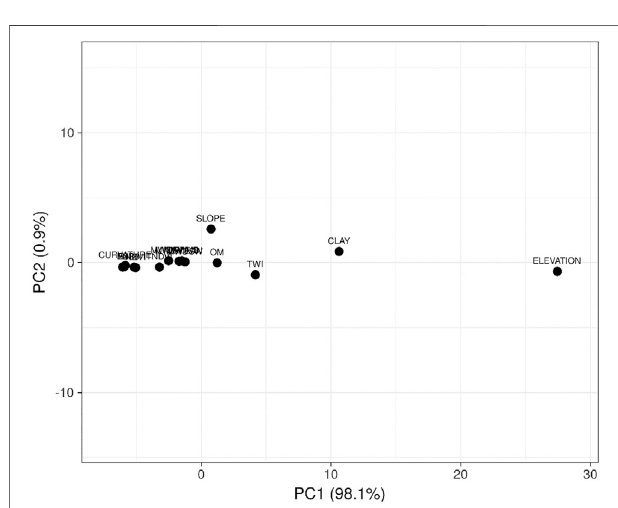
FIGURE 6 | PCA scatter lot showing the variable contribution in the dataset. X and Y axis show principal component 1 and principalcomponent 2 that explain 98.1 and 0.9% of the total